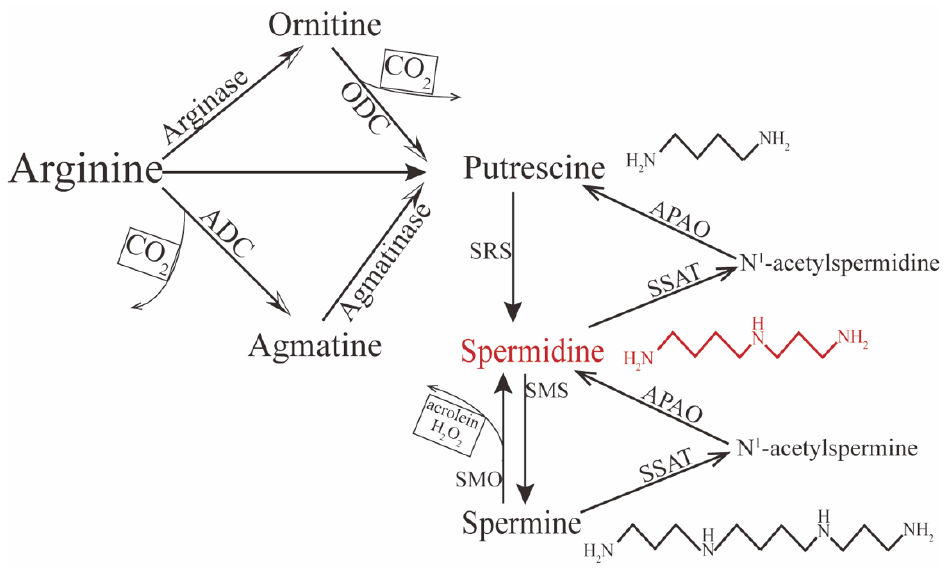
Figure 1. Polyamine’s synthesis and catabolism in mammals.